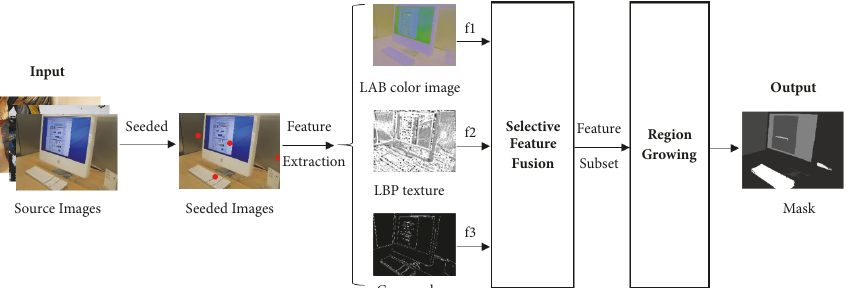
Figure 1: The pipeline of our method.